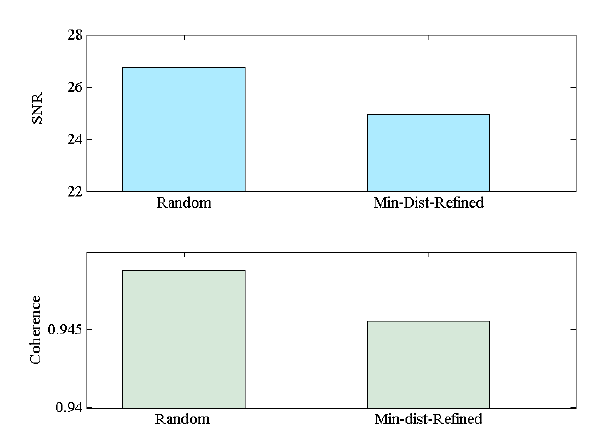
Figure 12. Impact of proposed algorithm on coherence and received SNR at